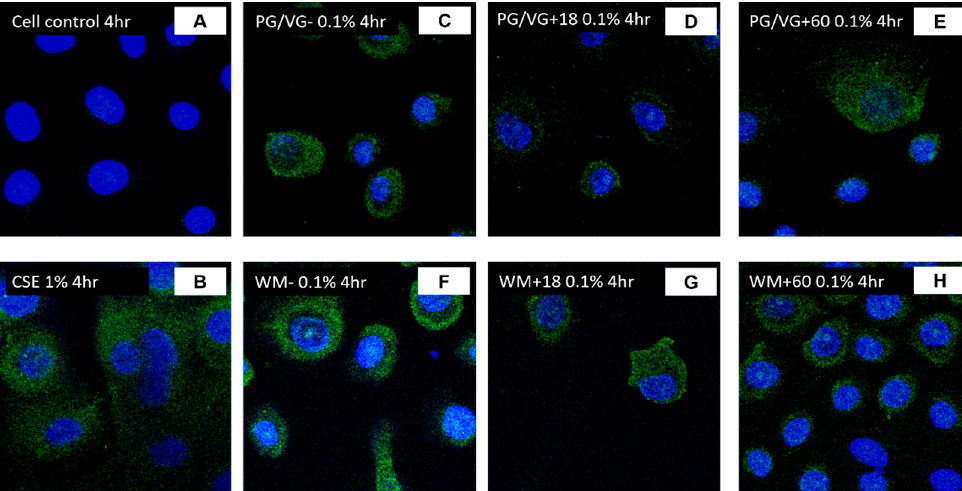
Figure 12. ACE2 protein expression of SAECs following CSE and electronic cigarette aerosol (PG/VG or WM) exposure: Small airway epithelial cells (SAECs) were exposed to a concentration (0.1%) of electronic cigarette condensate generated from PG/VG or WM ± nicotine or to 1% CSE for 4 h. Protein expression of ACE2 was assessed through immunofluorescence staining for 4 h ( B – H ) treatment in comparison with cell control ( A ). Images at 40×.